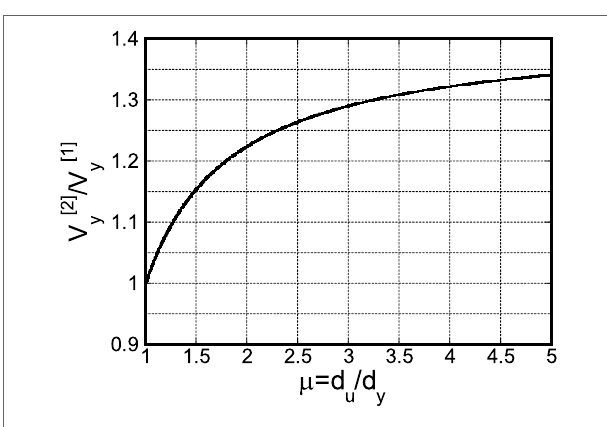
FIGURE 13 | V [2] y = V [1] y for μμμ = d u / d y .